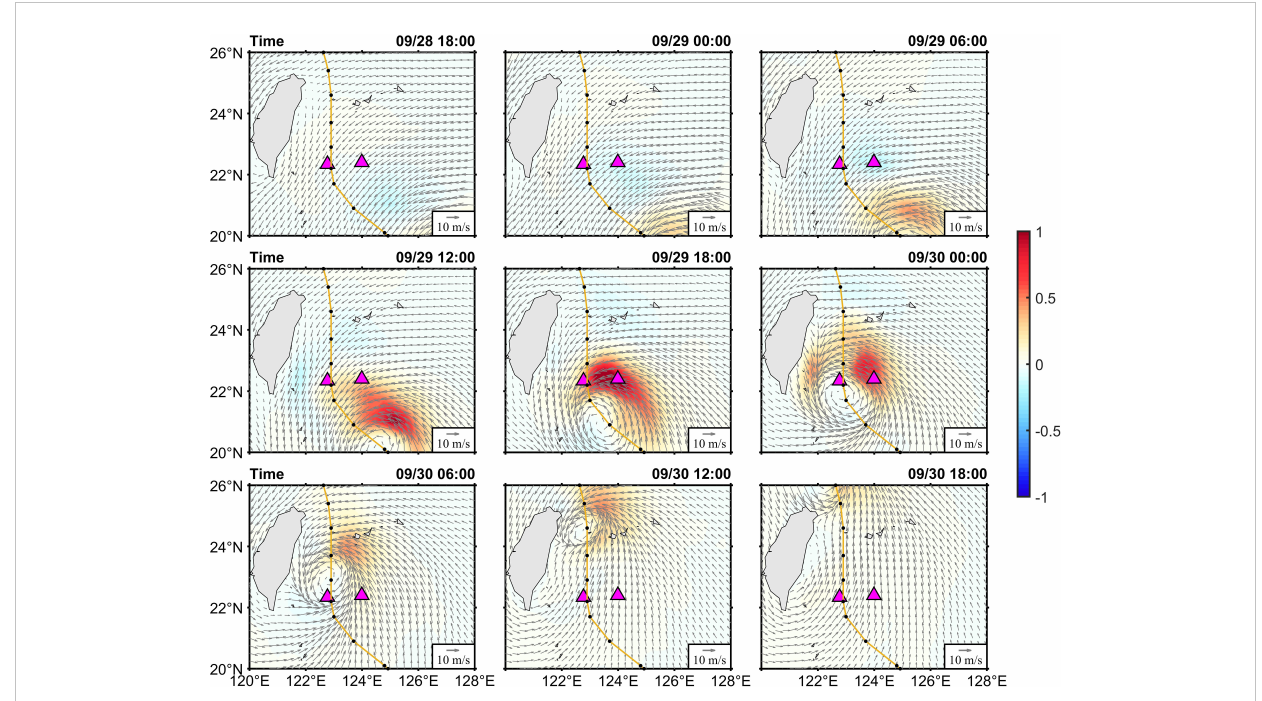
FIGURE 4 The near-inertial energy fl ux in the mixed layer (color shading, unit: W/m 2 ) calculated from slab model and wind speed (arrows) from 26 to 30 September 2019. The yellow lines represent the trajectory of Typhoon